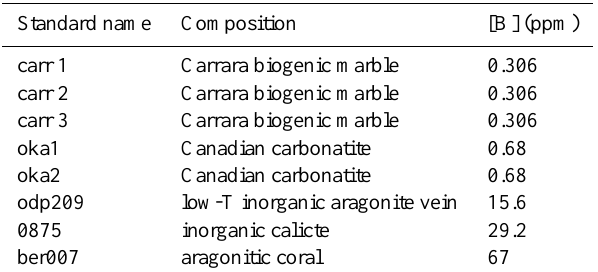
Table 1. List of standards and their absolute B